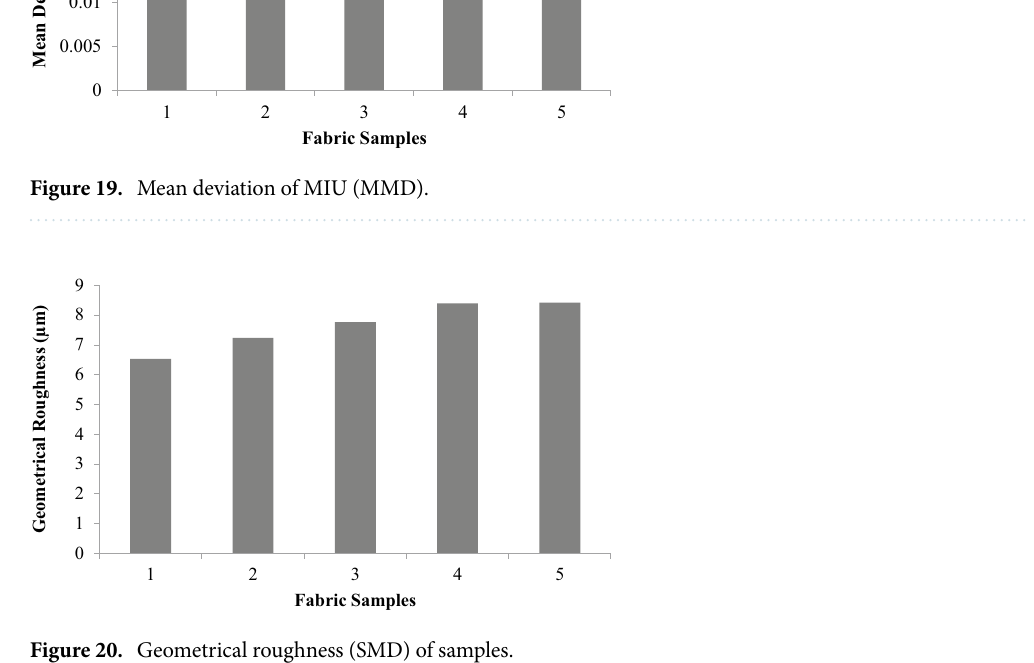
Figure 20. Geometrical roughness (SMD) of samples.